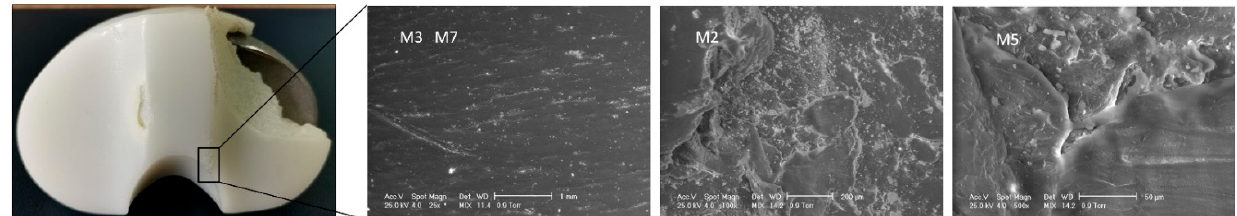
Figure 11. SEM images obtained for IT4 sample.